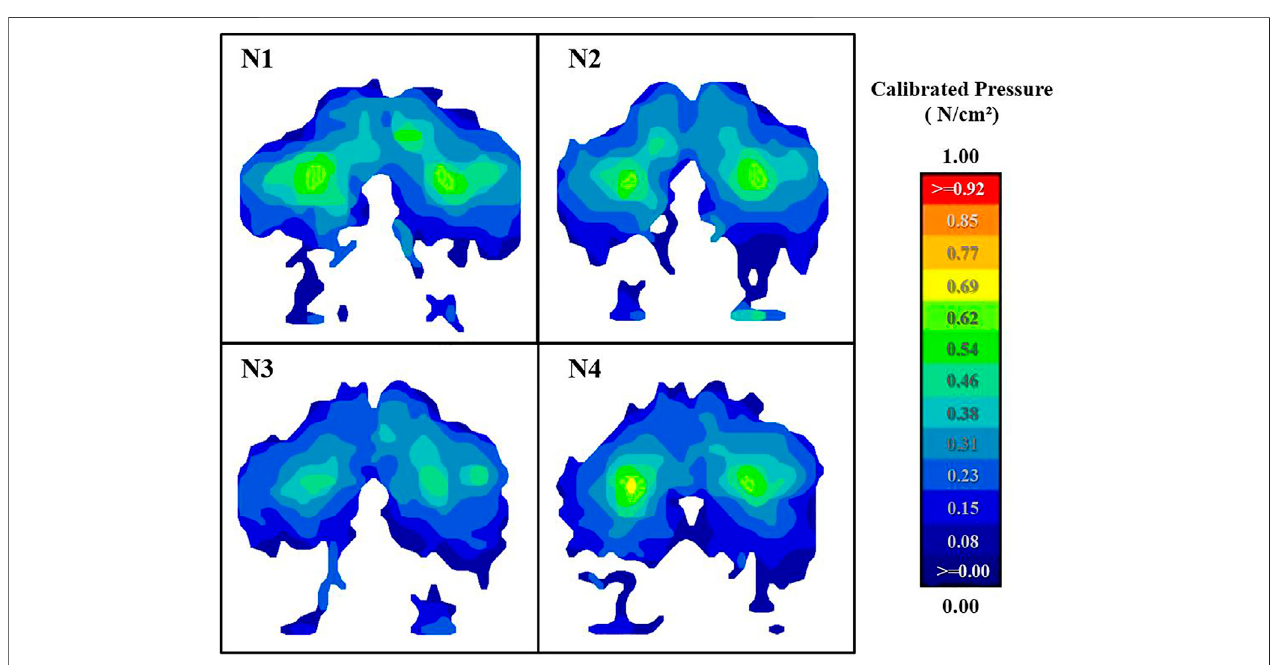
FIGURE 7 | The average pressure distribution of one participant with 60.12 kg sitting on the four types of